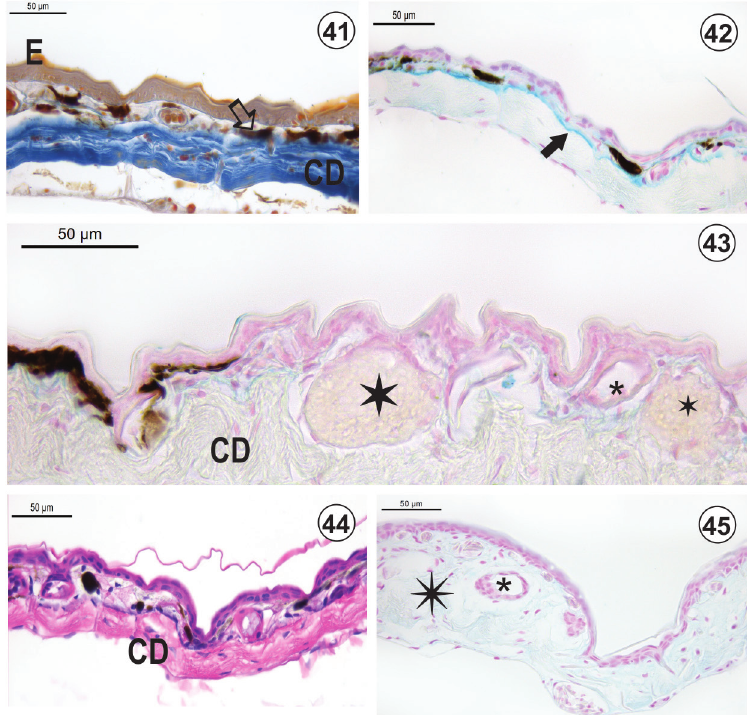
Figures 41–45. Light micrograph of the integument of O. trapicheroi : (41) Dorsal region (Mallory´s trichrome staining); (42) Dorsal region (AB-method); (43) Ventrolateral region (AB-method); (44) Ventral region (HE-staining); (45) Ventral region (AB-method). Melanophores ( _ ) occur in the spongious dermis of the dorsal integument, and in the ventrolateral region as isolated groups. They are absent in the ventral integument. In the dorsal region, the EK-layer ( Æ ) is continuous and well stained by the AB-method. Isolated serous glands ( Ø ) occur in all integument regions. The apocrine glands with granular content ( ¬ ) are visualized in the ventrolateral integument, where they are more developed. In the ventral region, cutaneous elevations ( â ) are also separated by grooves. The dermis contains several small blood vessels. E= epidermis; CD = compact dermis.